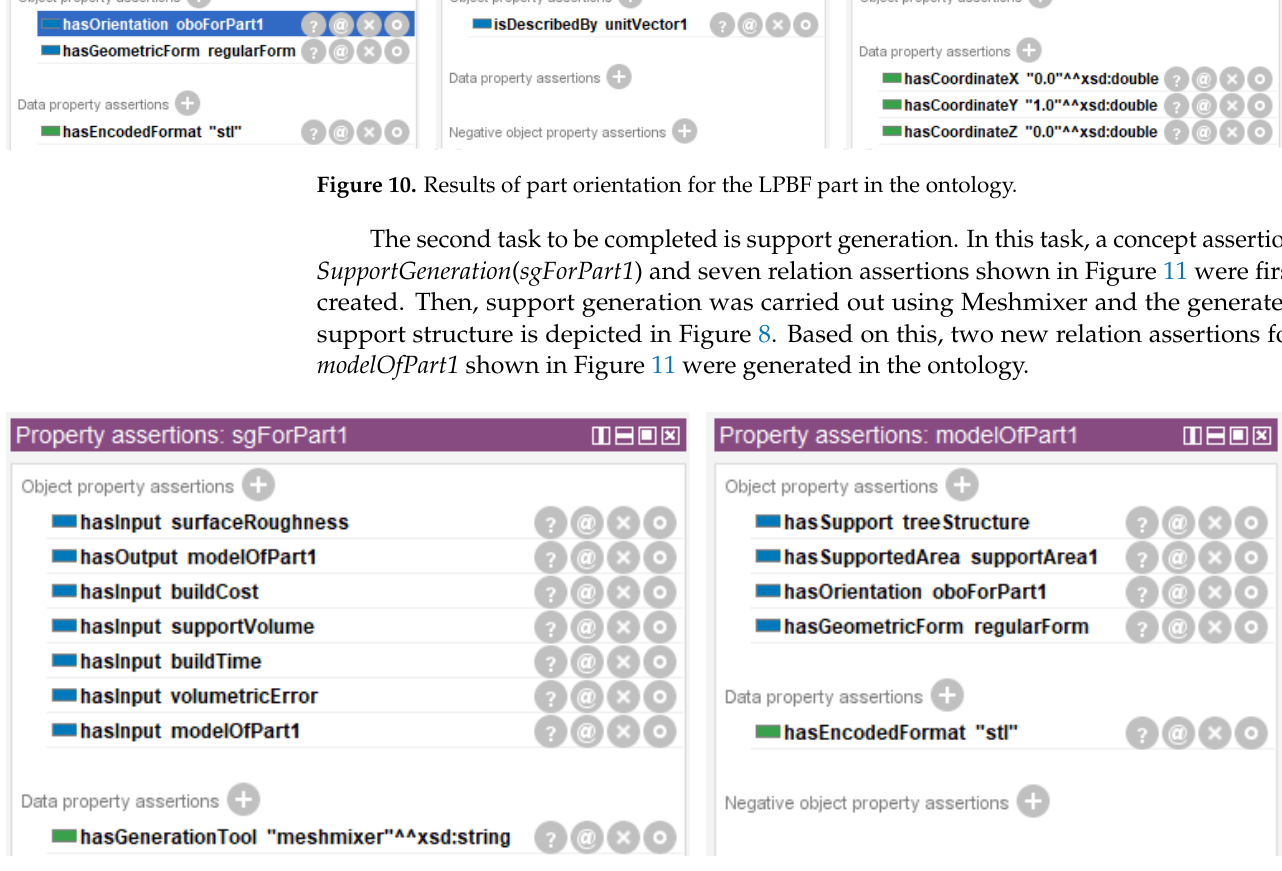
Figure 11. Results of support generation for the LPBF part in the